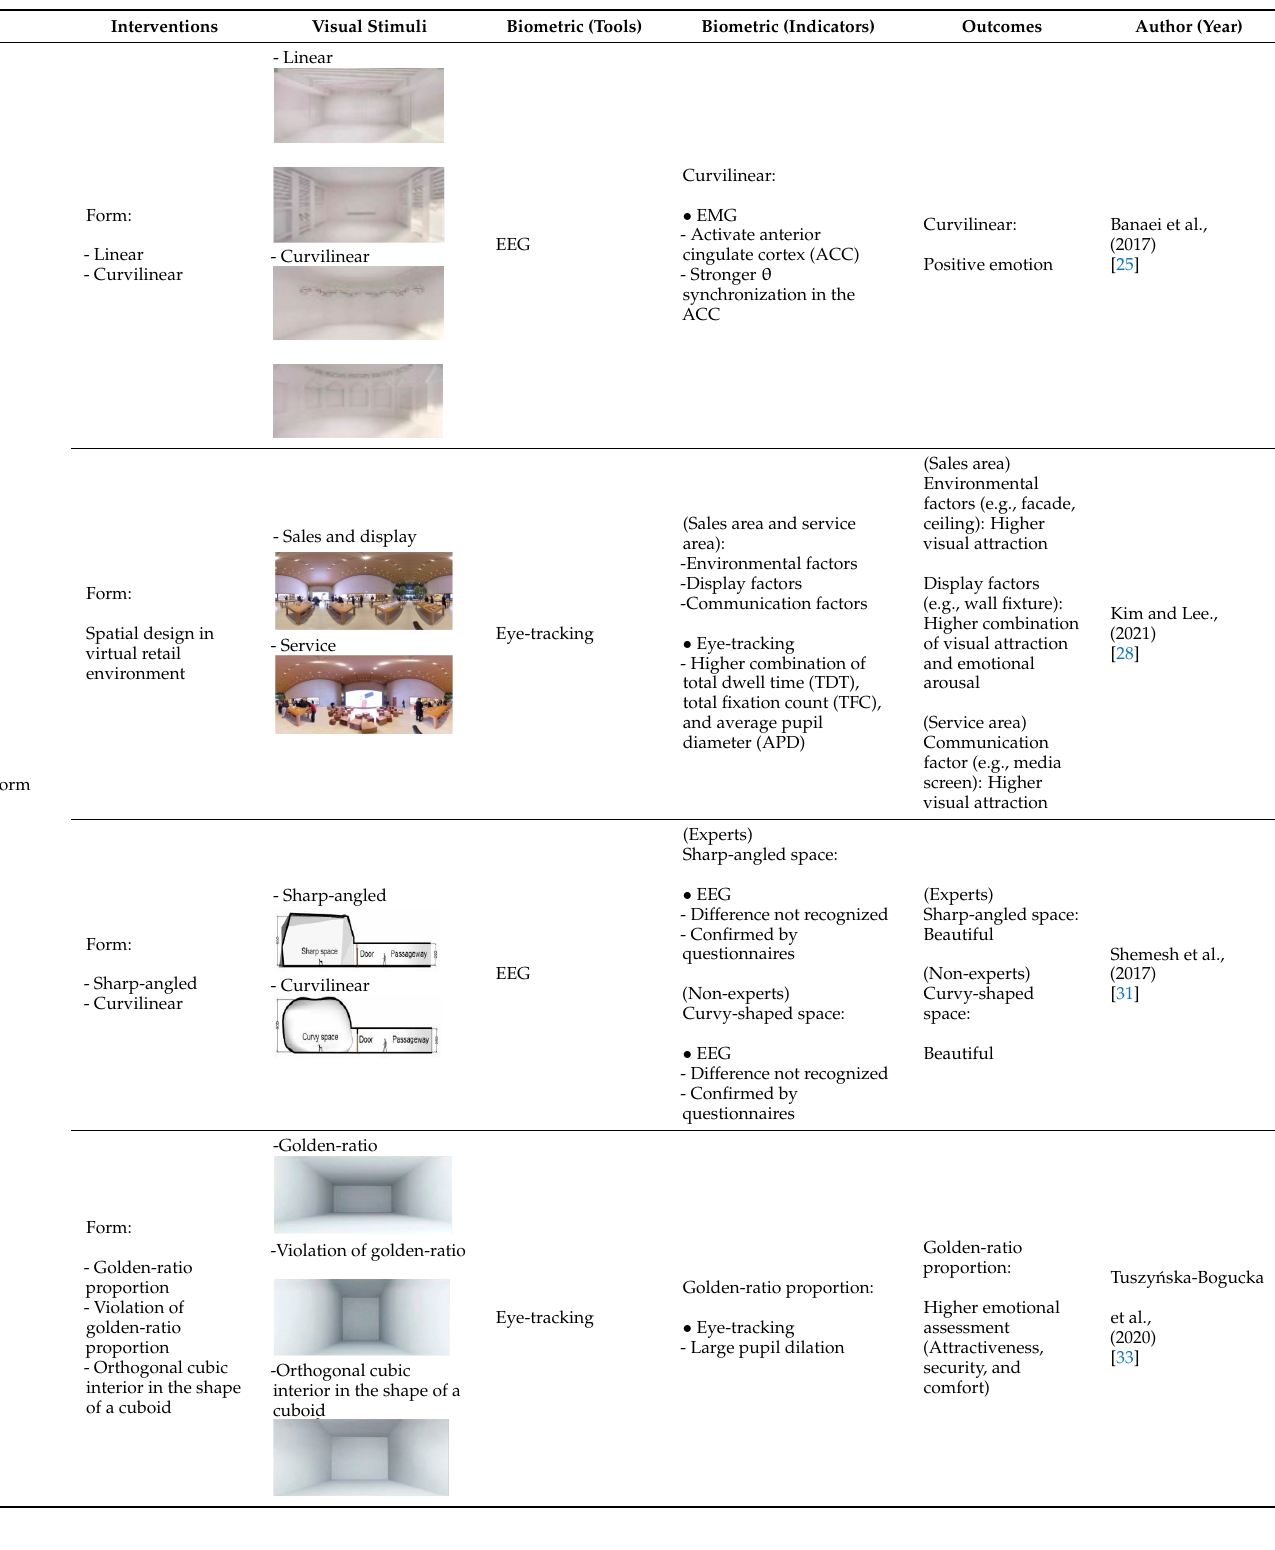
Table 3. Summary of design variables, biometric tools, and outcomes.